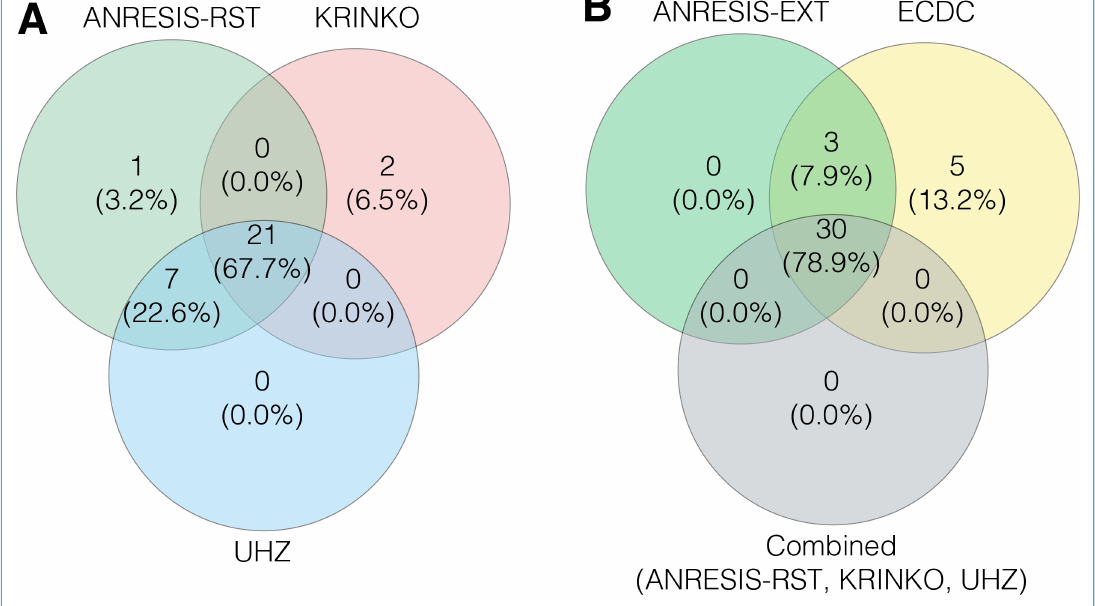
Figure S6: A) Overlap in the number of Acinetobacter spp. isolates classified as MDR following the application of the KRINKO, UHZ and AN- RESIS-RST definitions. B) Overlap in the number of Acinetobacter spp. isolates classified as MDR after application of the ECDC, ANRESIS- EXT definition and the combined MDR cases found with the KRINKO, UHZ and ANRESIS-RST definition. MDR, multiple drug resistance; ECDC, European Centre for Disease Prevention and Control; KRINKO, Commission for Hospital Hygiene and Infection Prevention; UHZ, Uni- versity Hospital Zurich; ANRESIS, Swiss Centre for Antibiotic Resistance; RST, restricted; EXT,